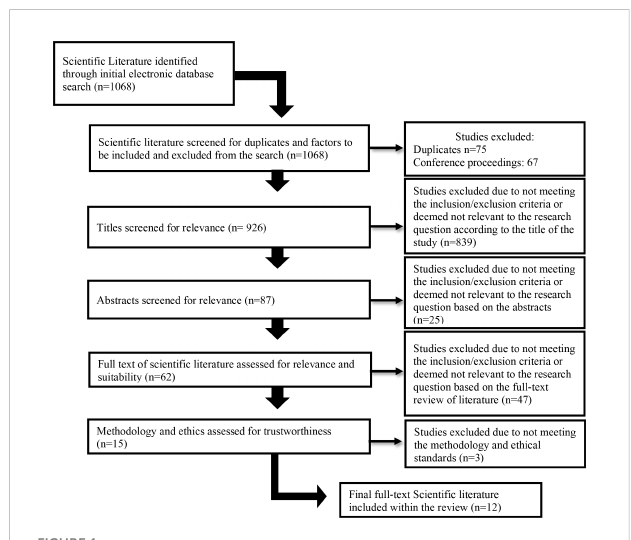
FIGURE 1 Flow chart of critical literature review and inclusion or exclusion